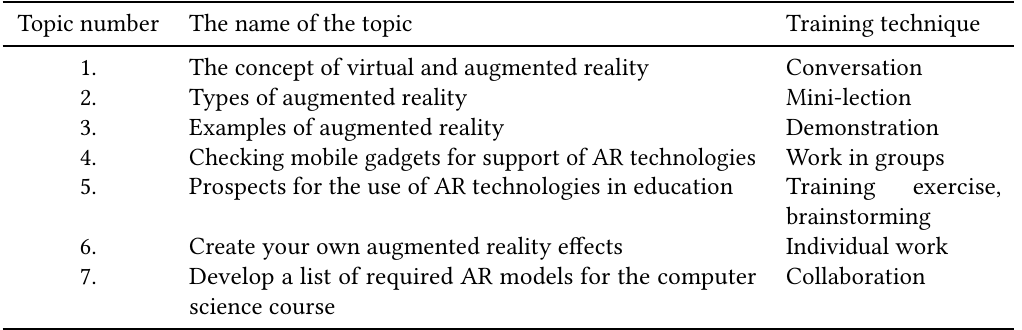
Table 2 Augmented reality training